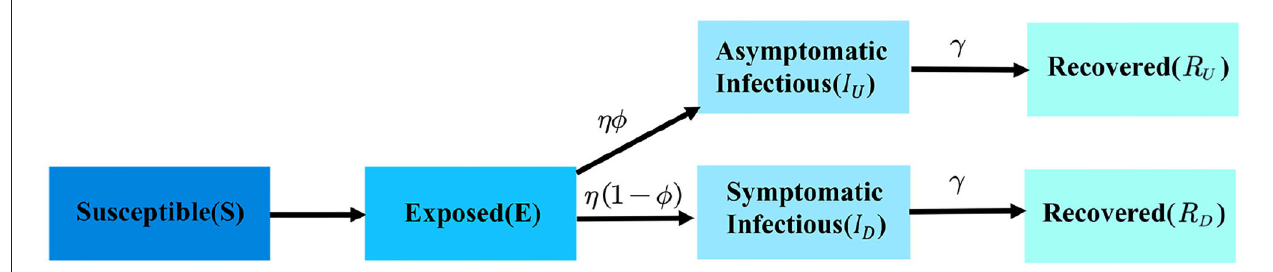
FIGURE 3 | The framework of SEI U I D R U R D model.